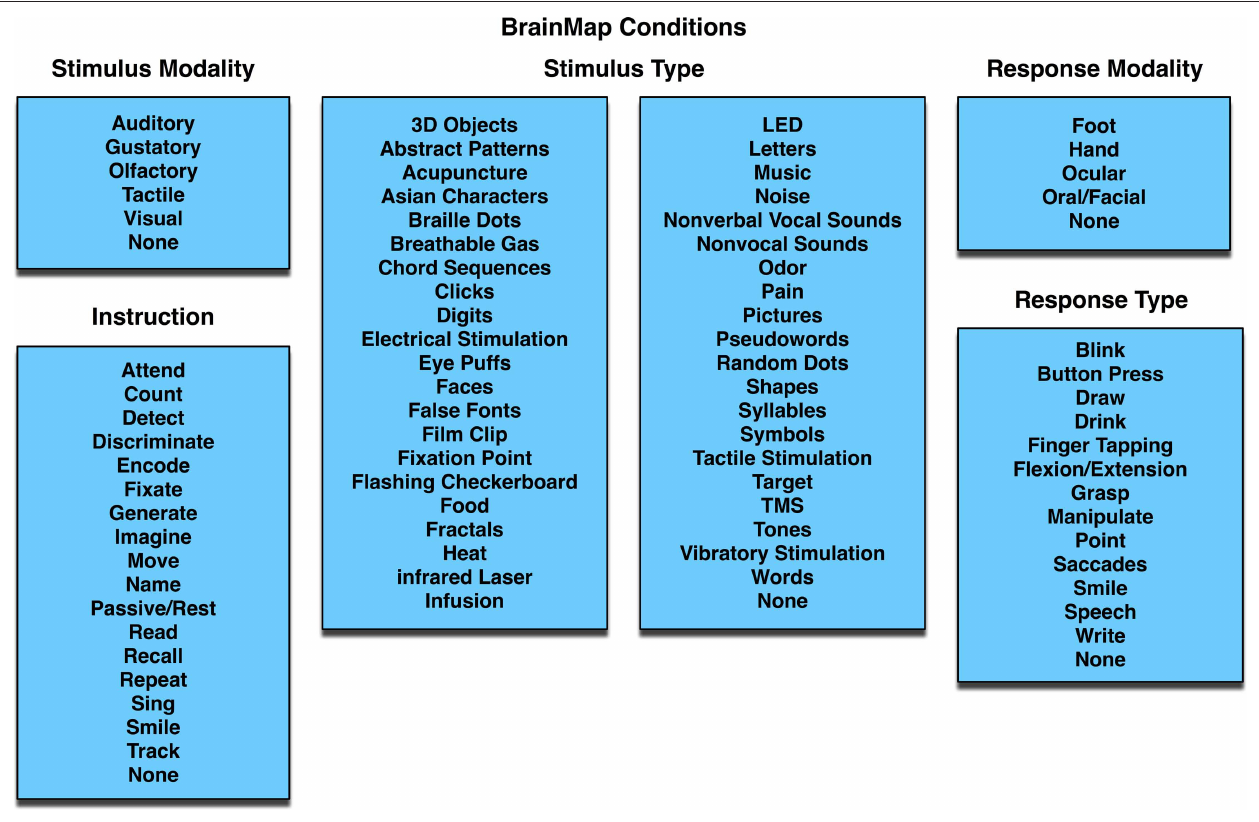
FIGURE 5 | BrainMap conditions. In each paper archived in BrainMap, the scanned experimental conditions can be segregated into components based on the stimulus presented (modality and type), instructions given, and required